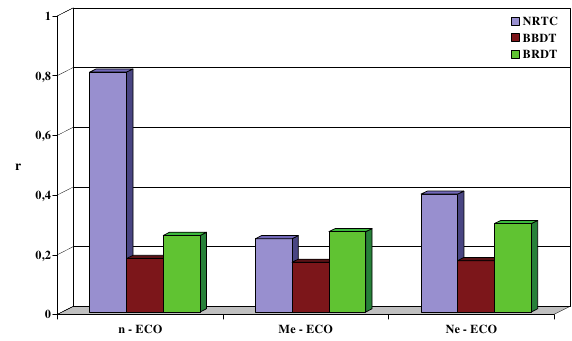
Fig. 18. The coefficient of Pearson’s linear correlation – r of carbon mon- oxide emission intensity with engine speed, torque and effective power